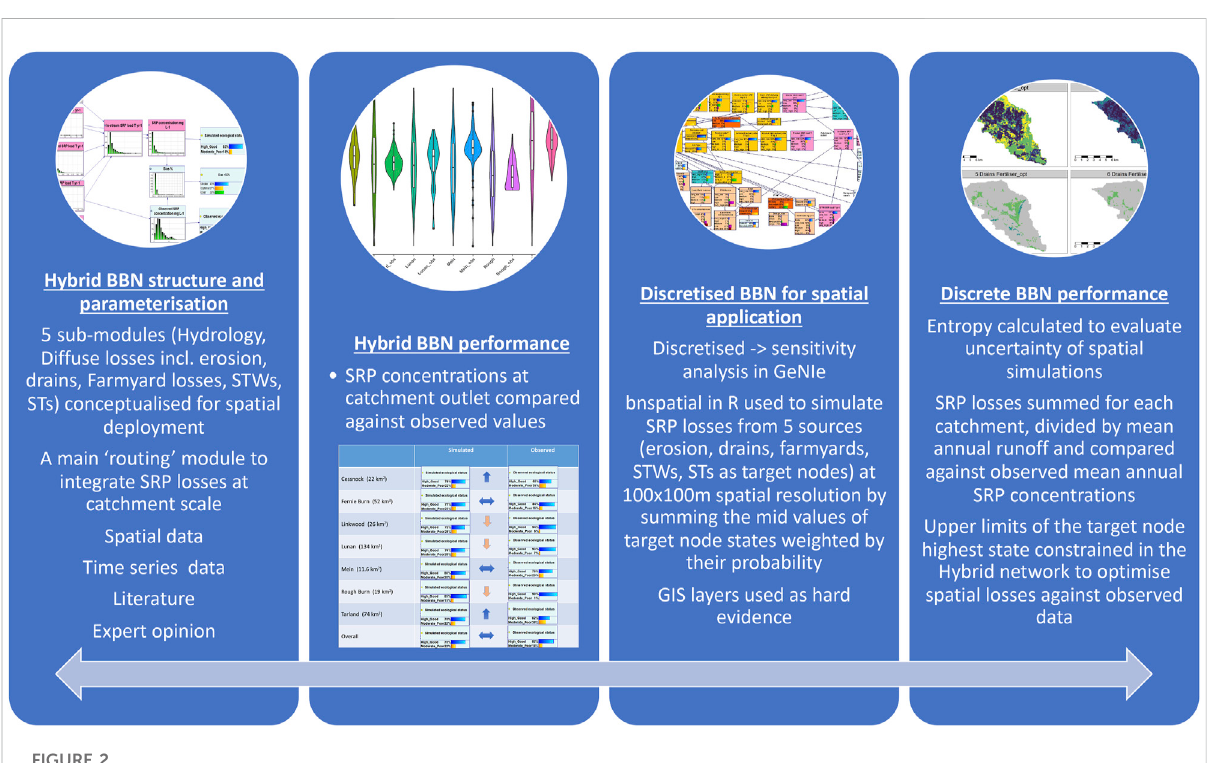
FIGURE 2 Conceptual diagram of model building steps and validation of the hybrid and discretised spatial model implementations. Two-way arrow indicates iterative manual calibration of the spatial model by adjusting the upper limit of the highest target node state in the hybrid